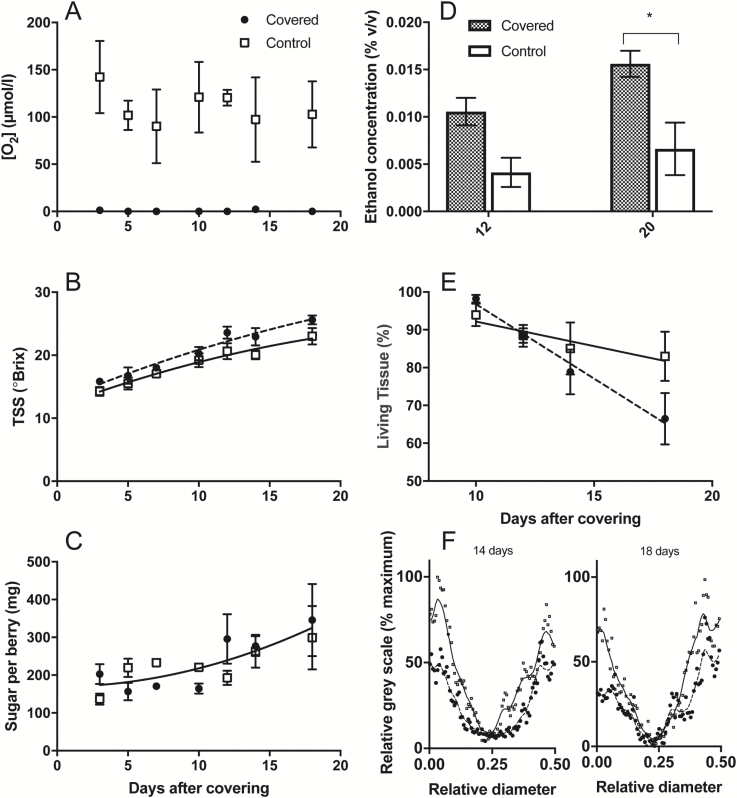
The effect of covering berry pedicels with silicone grease on intact Chardonnay clusters during ripening (chamber grown 2017, open squares=control, filled circles =covered). (A) [O2] at the approximate centre axis of berries as a function of time after covering pedicels. Two-way ANOVA showed that covering pedicels reduced [O2] (P<0.0001). (B) Total soluble solids (TSS) concentration of berries as a function of time after covering pedicels. Pedicel-covered berries showed significantly higher TSS during the course of the experiment compared with control berries (two-way ANOVA P=0.003; fits are second-order polynomials, solid line=control, dashed line=covered). (C) Sugar per berry as a function of time after covering pedicels. No significant difference was found between treatments in sugar/berry (combined fit is a second-order polynomial, solid line). (D) Ethanol concentration of berries after 12 d and 20 d with (filled) and without (open) silicone grease covering the pedicels. Two-way ANOVA (Tukey’s multiple comparisons test) showed a significant difference at 20 d after covering (P=0.036). (E) Percentage living tissue as a function of time. The slope of the fitted line for covered berries (dashed line) is non-zero (P=0.008) and different from the slope of the fitted line (solid line) for uncovered berries (P=0.006). (F) Fluorescence signal (FDA stain, relative to maximum, high value=higher living tissue) across the radius at the equator normalized for variation in berry diameter at 14 d and 18 d after covering. Locally weighted scatterplot smoothing fits (LOWESS) are shown for each. Covered (dashed line) versus control (solid line) are significantly different at both times (two-way ANOVA, P<0.001). Data are means ±SE, n=3, except (F) where SEs are not shown.